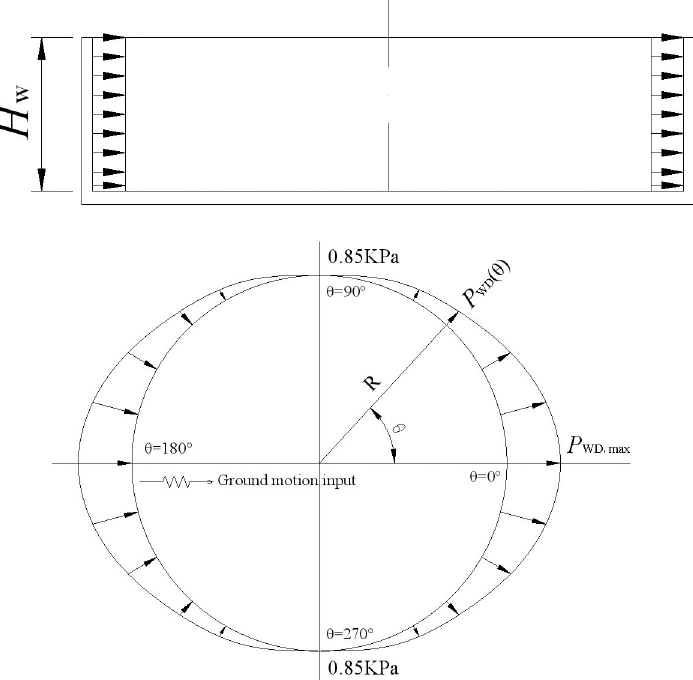
Fig 16. Hydrodynamic pressure distributions of the ground rested circular RC tank. a) Along the height of the tank wall. b) Along the circumferential direction of the tank bottom. https://doi.org/10.1371/journal.pone.0265528.g016 unidirectional horizontal seismic action, the hydrodynamic pressure under bi-directional hor- izontal seismic action can be represented by the hydrodynamic pressure distribution of the tank wall at the position of the maximum hydrodynamic pressure in the circumferential direc- tion of the tank bottom. Tables 13 and 14 respectively list the maximum hydrodynamic pres- sure of the whole tank under unidirectional main and secondary seismic motion with 1.0 m/s 2 peak acceleration. Table 15 lists the maximum hydrodynamic pressure of the whole tank under bi-directional seismic motions with 1.0 m/s 2 peak acceleration. By analyzing and comparing the calculation results of hydrodynamic pressure under unidi- rectional main seismic action input, unidirectional secondary seismic action input, and bi- directional seismic action input, the calculation formula of hydrodynamic pressure under bi- directional seismic action is fitted by direct addition, SRSS method, or reduced SRSS method. Three fitting methods are compared from the perspective of numerical reliability. SRSS method can ensure that the hydrodynamic pressure is reliable and the calculation is relatively